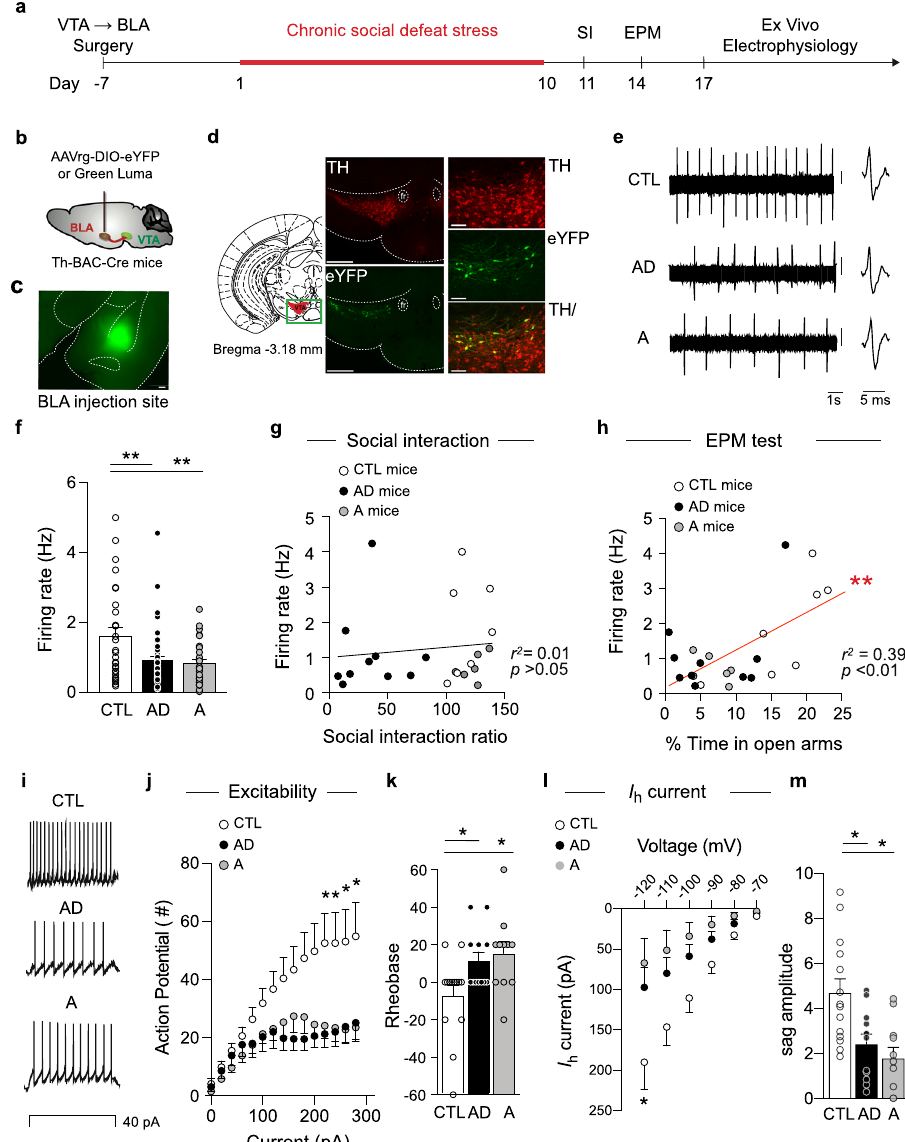
Fig. 2 Anxiety-like behavior correlates with the hypoactivity of VTA → BLA dopamine neurons. a Experimental timeline. b Schematic of the brain surgery to dissect VTA → BLA circuit. c BLA surgery injection site (scale bar = 500 μ m). d Morphological validation showing the targeted VTA → BLA dopamine neurons in TH-BAC-Cre mice injected with AAVrg-DIO-eYFP (scale bar = 500 and 100 μ m, representative images of the 23 recorded mice). e Sample traces of ex vivo cell-attached recordings from CTL, AD, and A mice (scale bar = 0.2mV). f Spontaneous fi ring activity of VTA → BLA dopamine neurons in AD and A mice compared to control mice (mean±s.e.m., ANOVA, F (2, 104) = 6.750 p = 0.0018; post hoc test, t = 3.48 p = 0.002; t = 3.50 p = 0.003, n = 30, 31, 45 neurons, n = 23 combined C57BL6/J and TH-BAC-Cre mice injected with AAVrg-DIO-eYFP and Green Luma, respectively). g Pearson correlation analyses of VTA → BLA dopamine neuron fi ring with the social interaction behavior after CSDS ( p = 0.59, 3 – 7 neurons per mouse, n = 23 combined C57BL6/J and TH- BAC-Cre mice). h Pearson correlation analyses of VTA → BLA dopamine neuron fi ring activity with the time in EPM open arms ( p = 0.0015, 3 – 7 neurons per mouse, n = 23 combined C57BL6/J and TH-BAC-Cre mice). i Sample traces of ex vivo whole-cell recordings from CTL, AD, and A mice at a 40 pA step current injection. j VTA → BLA dopamine neurons excitability in AD and A mice compared to CTL mice following incremental steps in currents injections (20 – 280 pA; mean ±s.e.m., RM two-way ANOVA: group effect: F (2, 33) = 3.818 p = 0.021; Interaction F (28, 434) = 3.164 p = 1.08e − 07; post hoc tests: t = 2.41 p = 0.04; t = 2.53 p = 0.04; t = 1.95 p = 0.04; t = 2.63 p = 0.04; t = 1.64 p = 0.04; t = 2.52 p = 0.04; t = 1.72 p = 0.04; t = 2.25 p = 0.04; n = 11, 12, 14 neurons/4, 5, 6 TH-BAC-Cre mice). k VTA → BLA dopamine neurons rheobase in AD and A mice compared to CTL mice (mean ±s.e.m., ANOVA: Group effect: F (2, 33) = 4.016 p = 0.013; post hoc tests t = 2.43 p = 0.04; t = 2.85 p = 0.02; n = 11, 13, 14 neurons/4, 5, 6 TH-BAC-Cre mice). l VTA → BLA dopamine neurons hyperpolarization-activated current, i.e., I h current in AD and A mice compared to CTL mice following incremental voltage steps (mean±s.e.m., RM two-way ANOVA: group effect: F (2, 33) = 4.194 p = 0.017; interaction F (10, 175) = 3.393 p = 9.7e − 06; post hoc tests t = 2.22 p = 0.04; t = 2.71 p = 0.025; n = 11, 13, 14 neurons/4, 5, 6 TH-BAC-Cre mice). m VTA → BLA dopamine neurons sag ratio in AD and A mice compared to CTL mice (mean±s.e.m., ANOVA: group effect: F (2, 32) = 7.225 p = 0.001; t = 3.04 p = 0.009; t = 3.79 p = 0.002, n = 11, 13, 14 neurons/4 – 6 TH-BAC-Cre mice). In all panels, two-sided statistical analyses post hoc corrected tests were performed, * p < 0.05, ** p < 0.01. See also Supplementary Fig. 3.